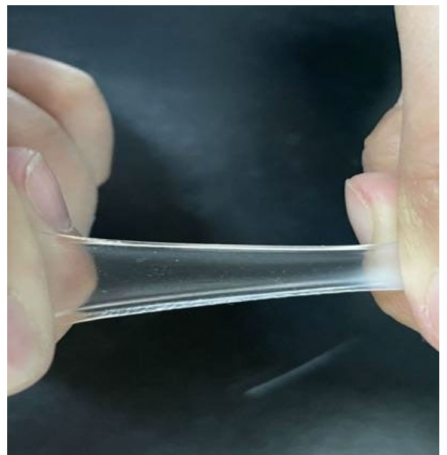
Figure 2. Photograph demonstrating the stretching effect of